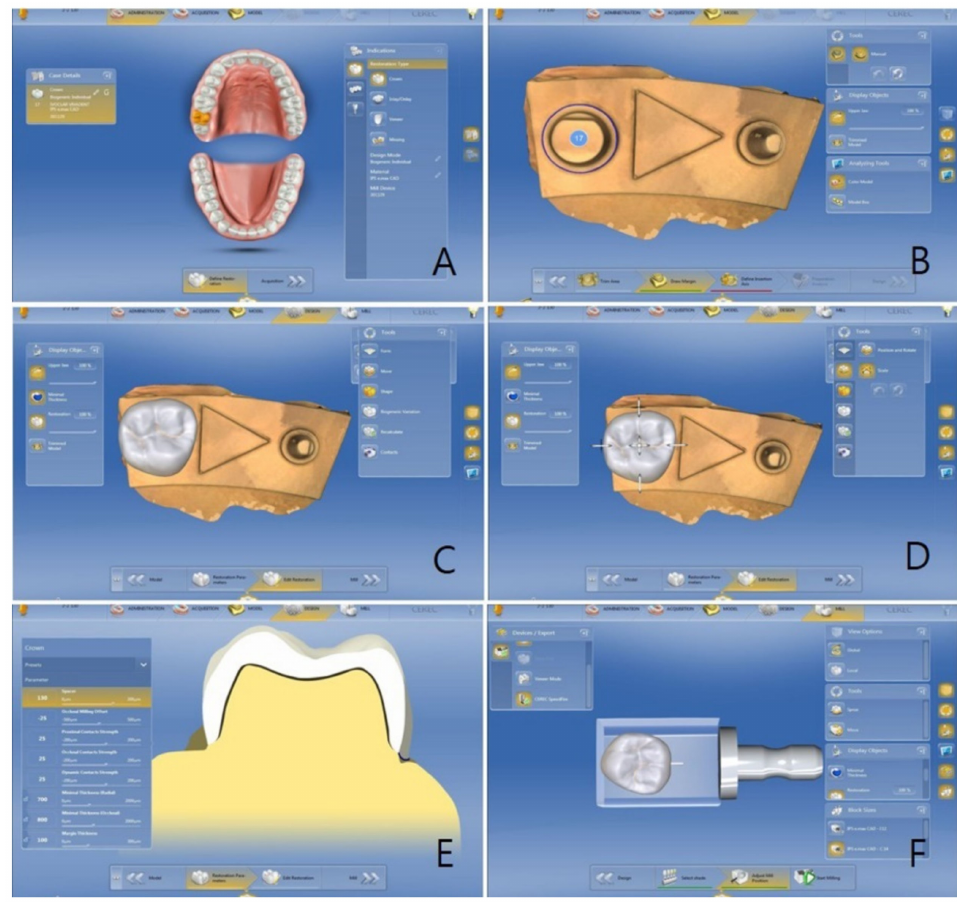
Figure 1. Crown design process using a computer-aided design and manufacturing software with the CEREC system. ( A ) Definition of a prosthesis (tooth selection, material selection, etc.); ( B ) mar- gin setting; ( C ) design suggestions; ( D ) design modification of the prosthesis (size, position, etc.); ( E ) parameter setting; ( F ) confirmation of the size and position in the block for